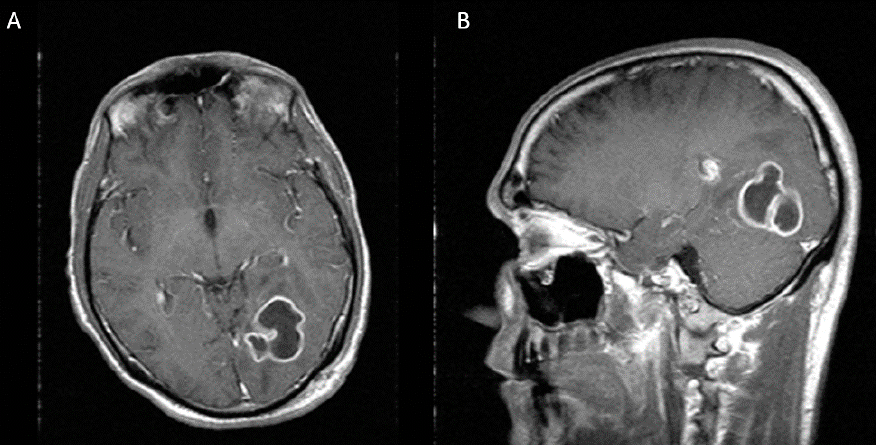
Figure 2. Two weeks after first stereotactic needle aspiration, MRI demonstrates an increase in the abscess size, now measuring 36 × 33 × 40 mm. ( A ) Axial view ( B ) Sagittal view. Diseases 2017 , 5 , 26